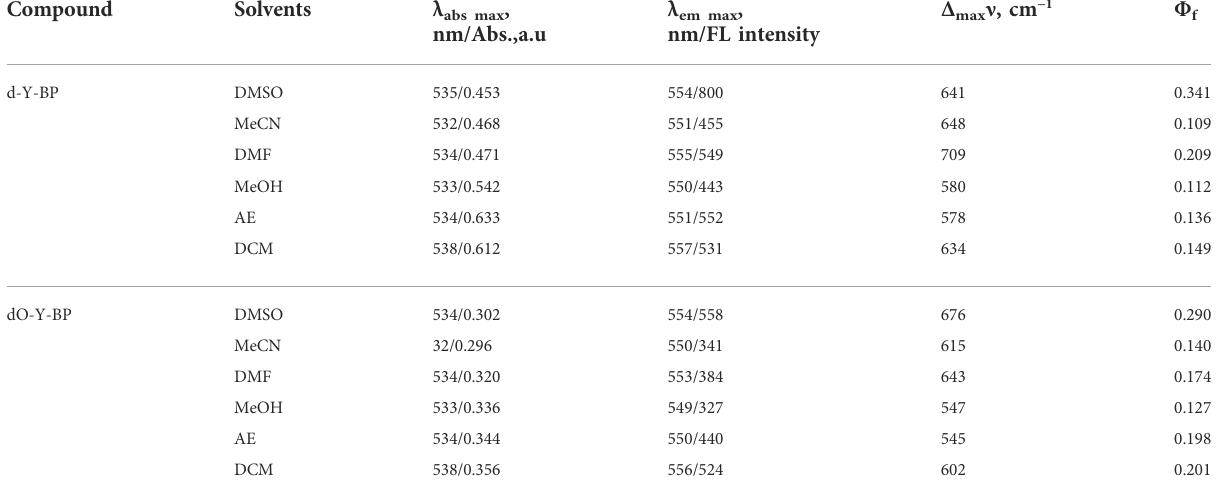
TABLE 1 Photophysical characteristic of d/dO-Y-BP in different solvents. Compound